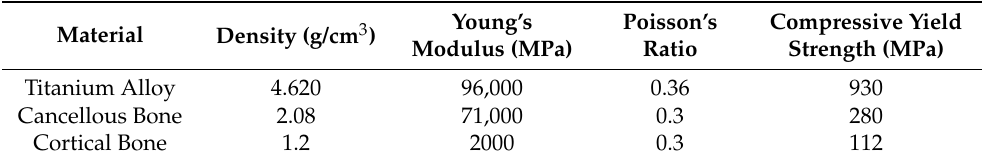
Table 1. Mechanical Properties of the Titanium Alloy.